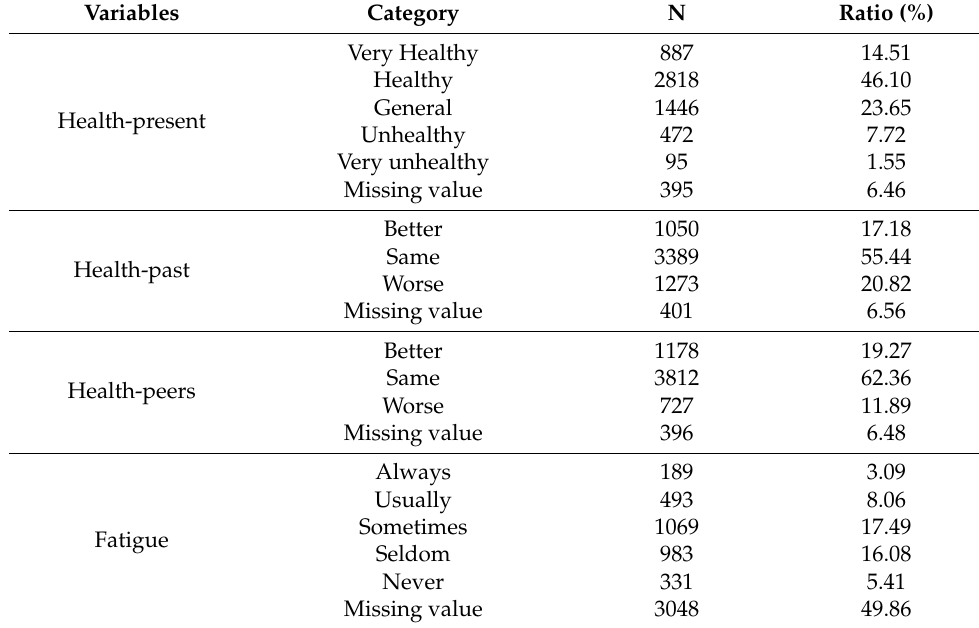
Table 1. Characteristics of the study